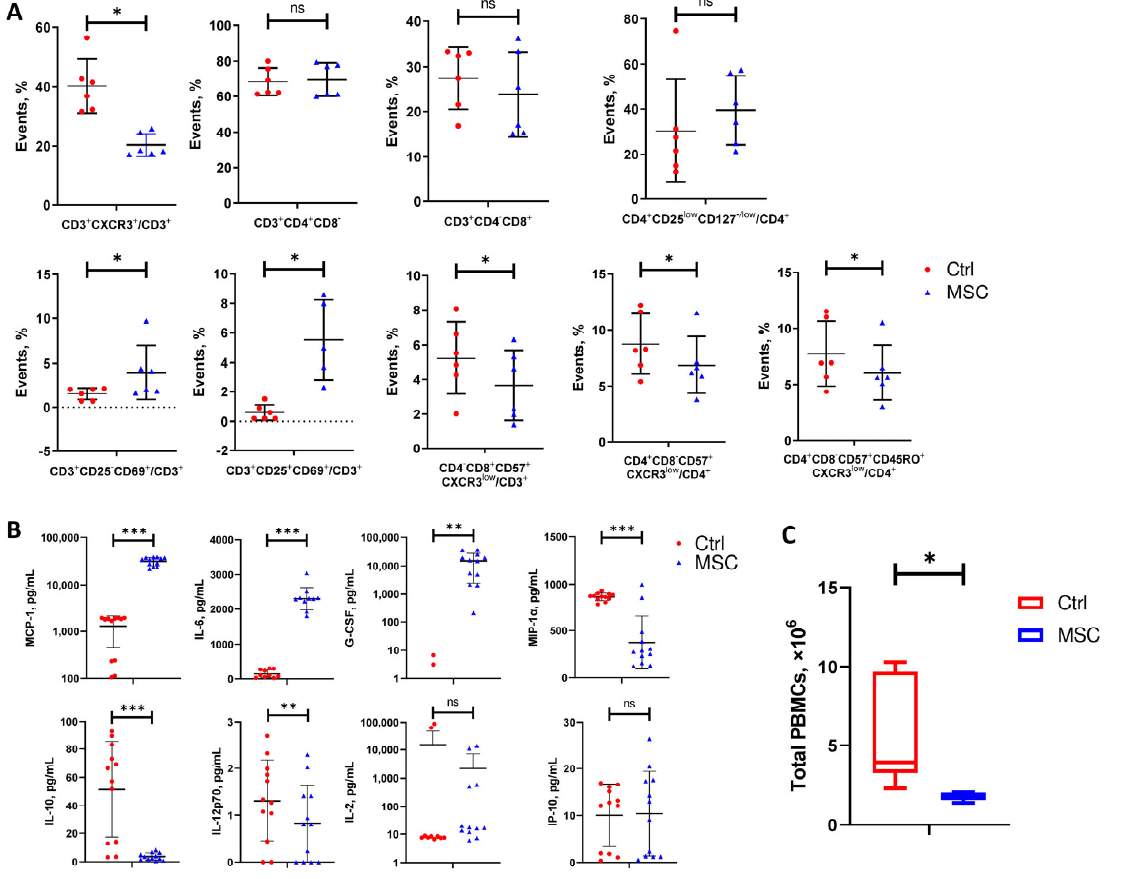
Figure 6. Changes in cell subpopulations’ ratios of COVID-19 patients-derived PBMC, cytokine levels in media, and total PBMC count after 6 days of co-culturing with or without UC-MSC. ( A ) Frequency of different T cells’ subpopulations. ( B ) Cytokine levels. ( C ) Difference between groups in total PBMC count collected from 6/24 wells. Data are presented as the mean with SD. Paired t-test was used for comparison between groups: *, p < 0.05; **, p ≤ 0.01; ***, p ≤ 0.001; ns, not significant. The red circle represents the Control PBMC group; the blue triangle represents the PBMC+UC-MSC group.